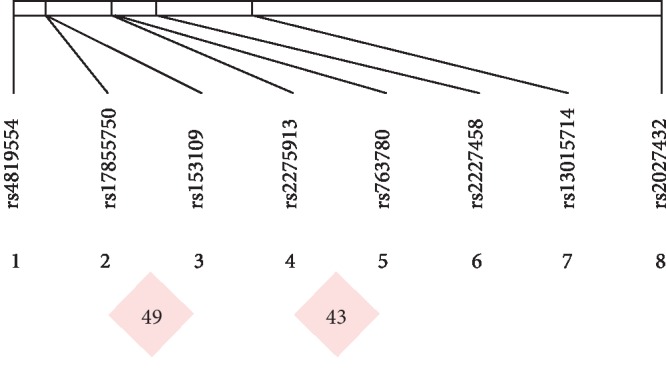
Inflammation-LD plot. We estimated the LD and haplotype using Haploview 4.2; rs153109 and rs17855750 (IL-27) and rs2275913 and rs763780 (IL-17) were in low LD with each other (r2 = 0.49 and r2 = 0.43, r2 < 0.8).